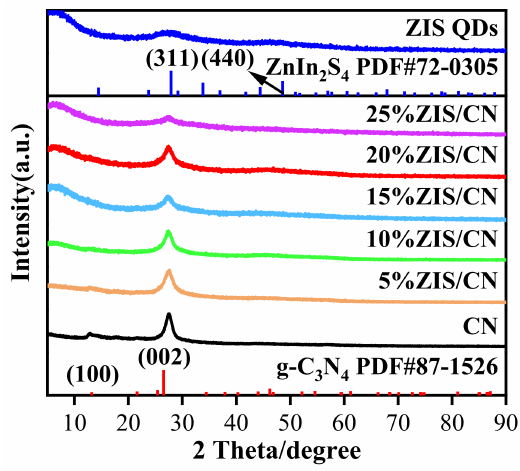
Figure 2. XRD patterns of CN, ZIS QDs and